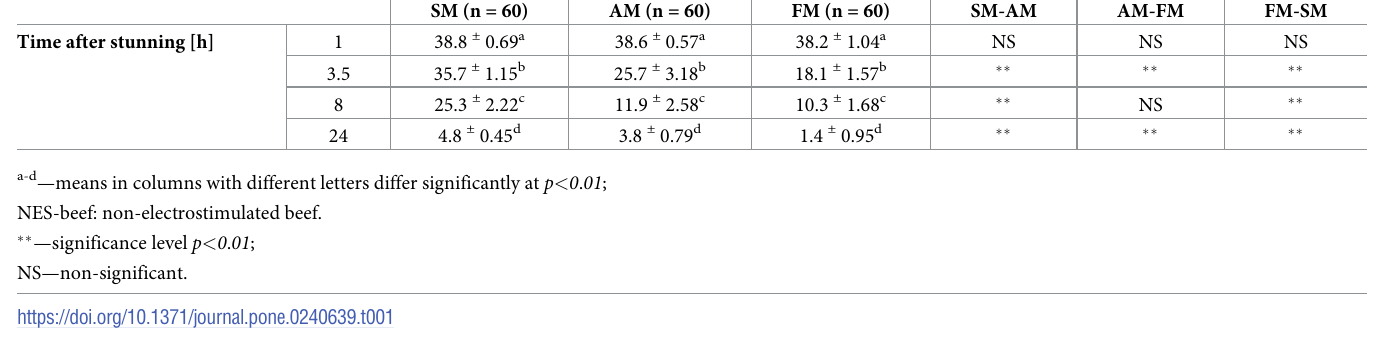
Table 1. Temperature changes (mean values ± standard deviation) during NES-beef chilling with the slow (SM), accelerated (AM), and fast (FM) methods. Experimental